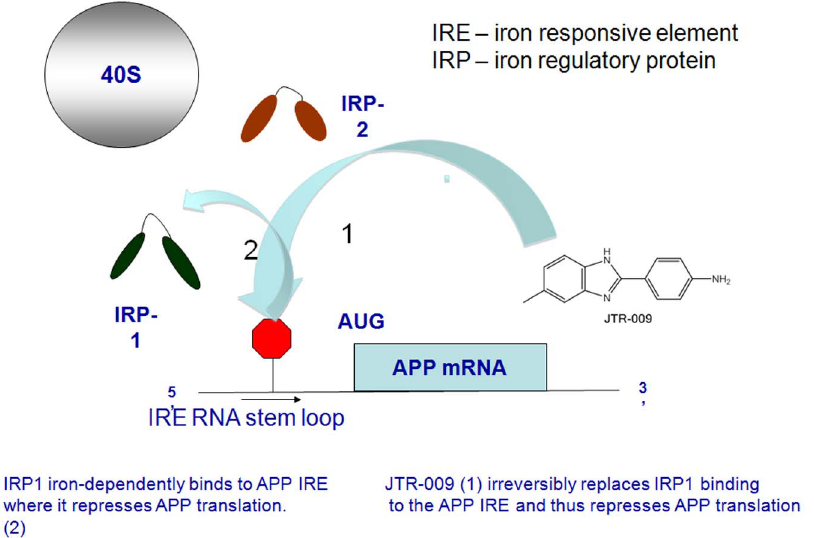
Figure 7. Model for the action of the bezimidazole JTR-009 to act as an inhibitor of APP translation by irreversibly replacing the iron dependent translation repressor IRP1 from interacting with APP 5 9 UTR sequences. Binding of JTR-009 selectively targeted APP 5 9 UTR sequences and then was found to repress APP levels leading to reduced amyloid levels without perturbing cellular iron uptake.